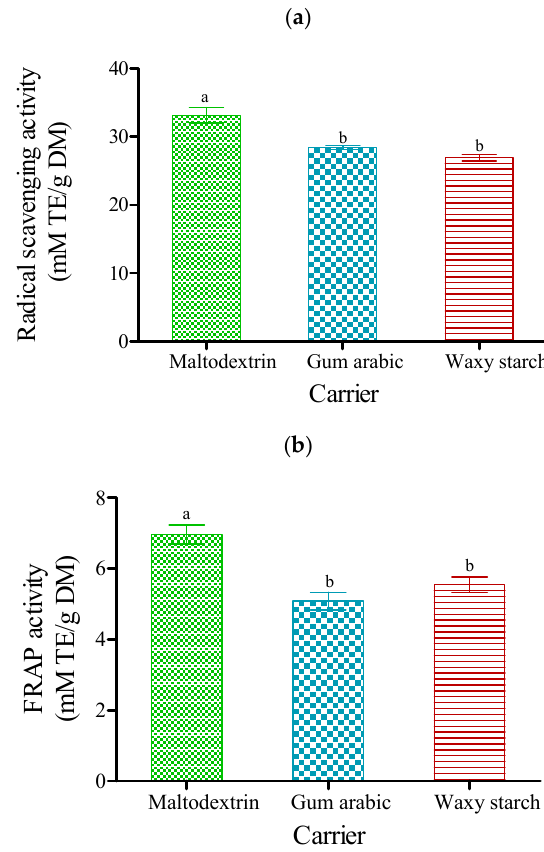
Figure 5. Antioxidant capacity ( a ) radical scavenging activity (RSA) and ( b ) ferric-reducing antioxidant power (FRAP) activity of freeze-dried pomegranate powder using di ff erent carriers. Bars with di ff erent letters are significantly di ff erent ( p < 0.05) according to Fisher’s LSD. Vertical bars indicate the standard error of the